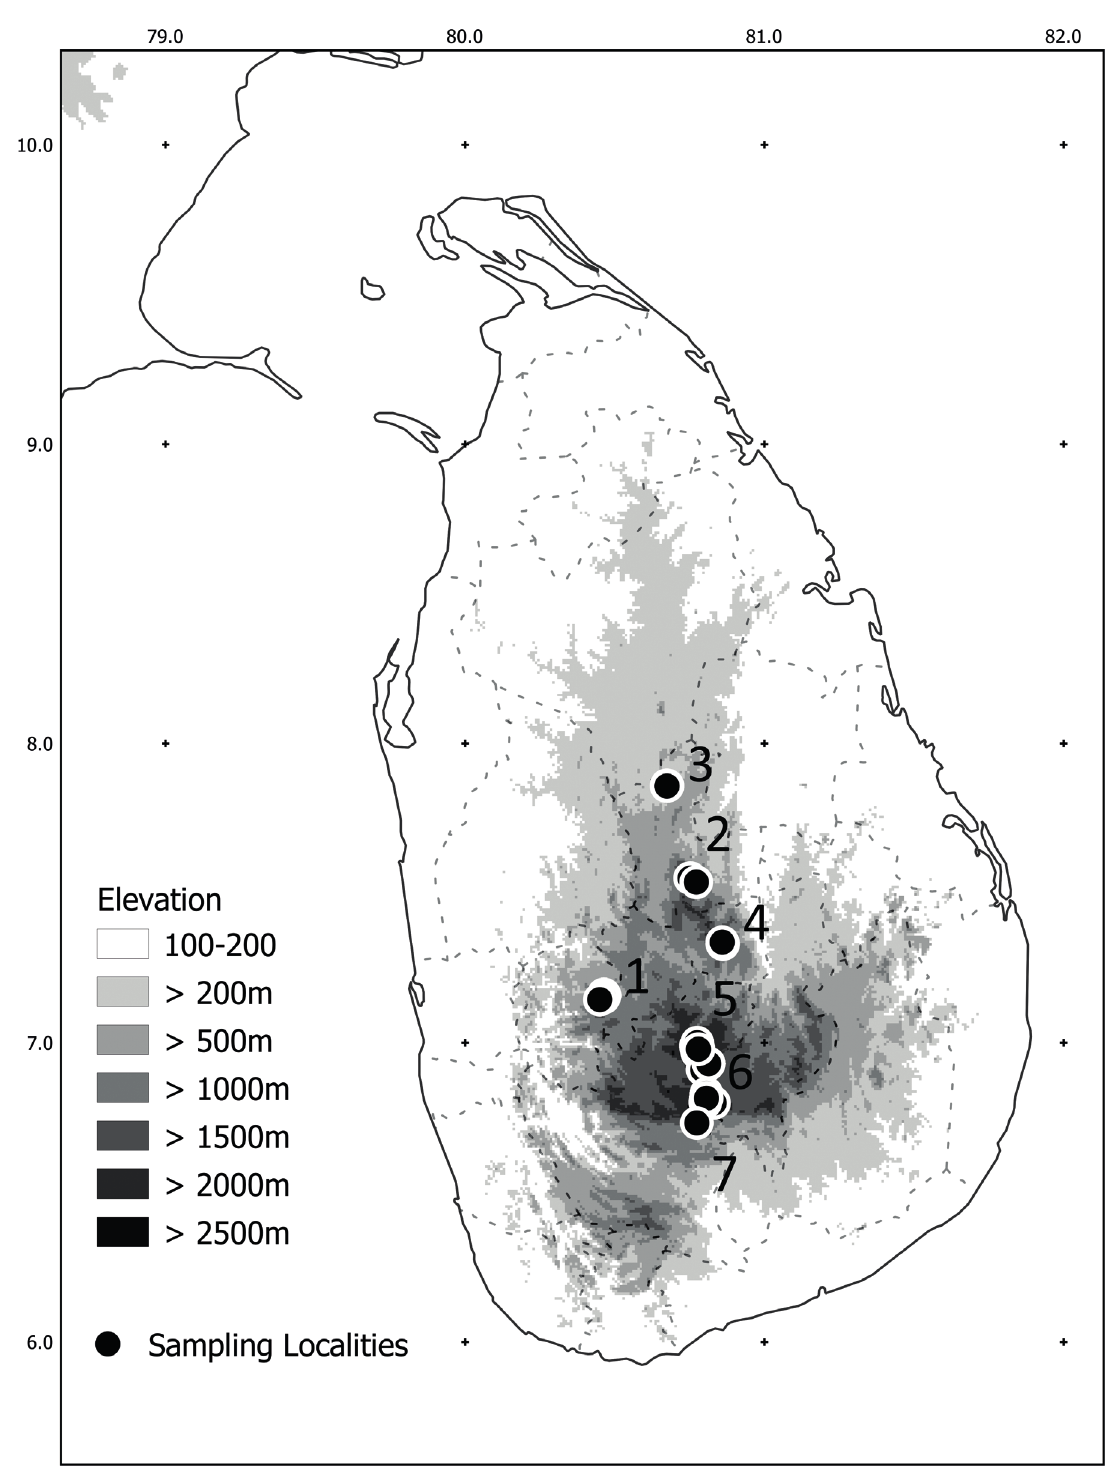
Fig. 1. Map of Sri Lanka showing collecting sites for this study. Numbers refer to major sampling localities. 1 = Aranayake; 2 = Riverston; 3 = NIFS Arboretum; 4 = Deenston; 5 = Nuwara Eliya; 6 = Horton Plains; 7 =